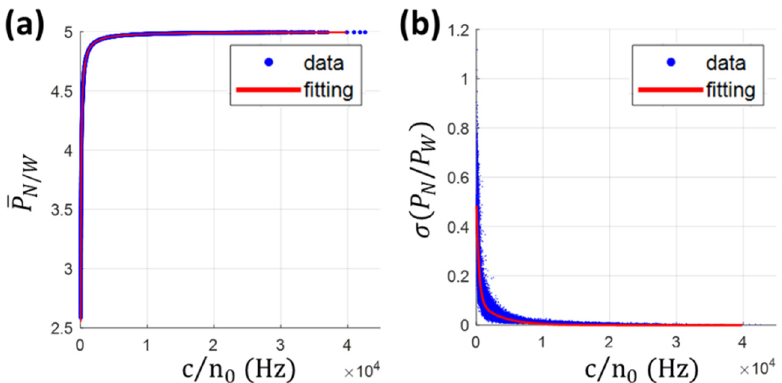
Figure 6. The curve fitting model for C/N 0 noise simulation based on large amount data in the urban scenario: ( a ) P N / W fitted by a rational model; ( b ) σ ( P N / P W ) fitted by an exponential